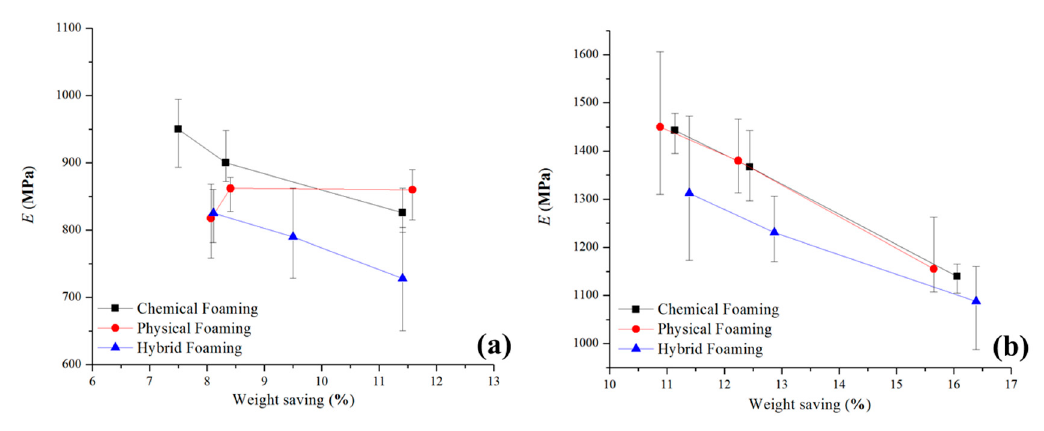
Figure 7. Young’s Modulus (E) against weight-saving ( a ) unfilled PP ( b ) talc-filled PP.